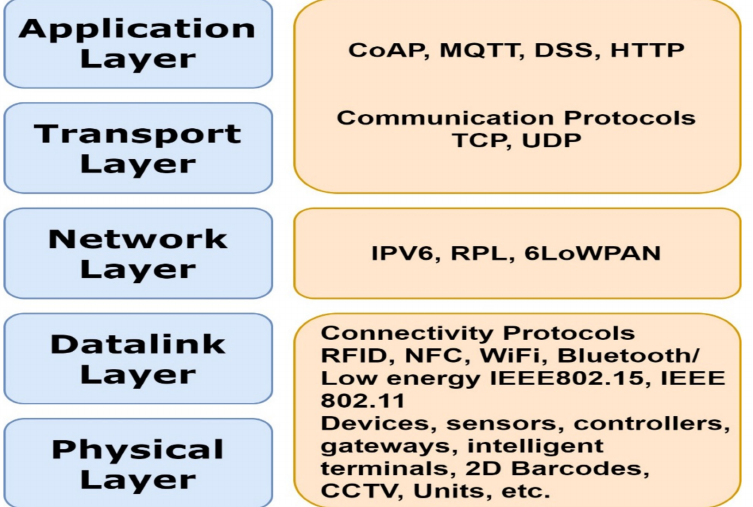
Figure 4. Communication standards and protocols following different layers of